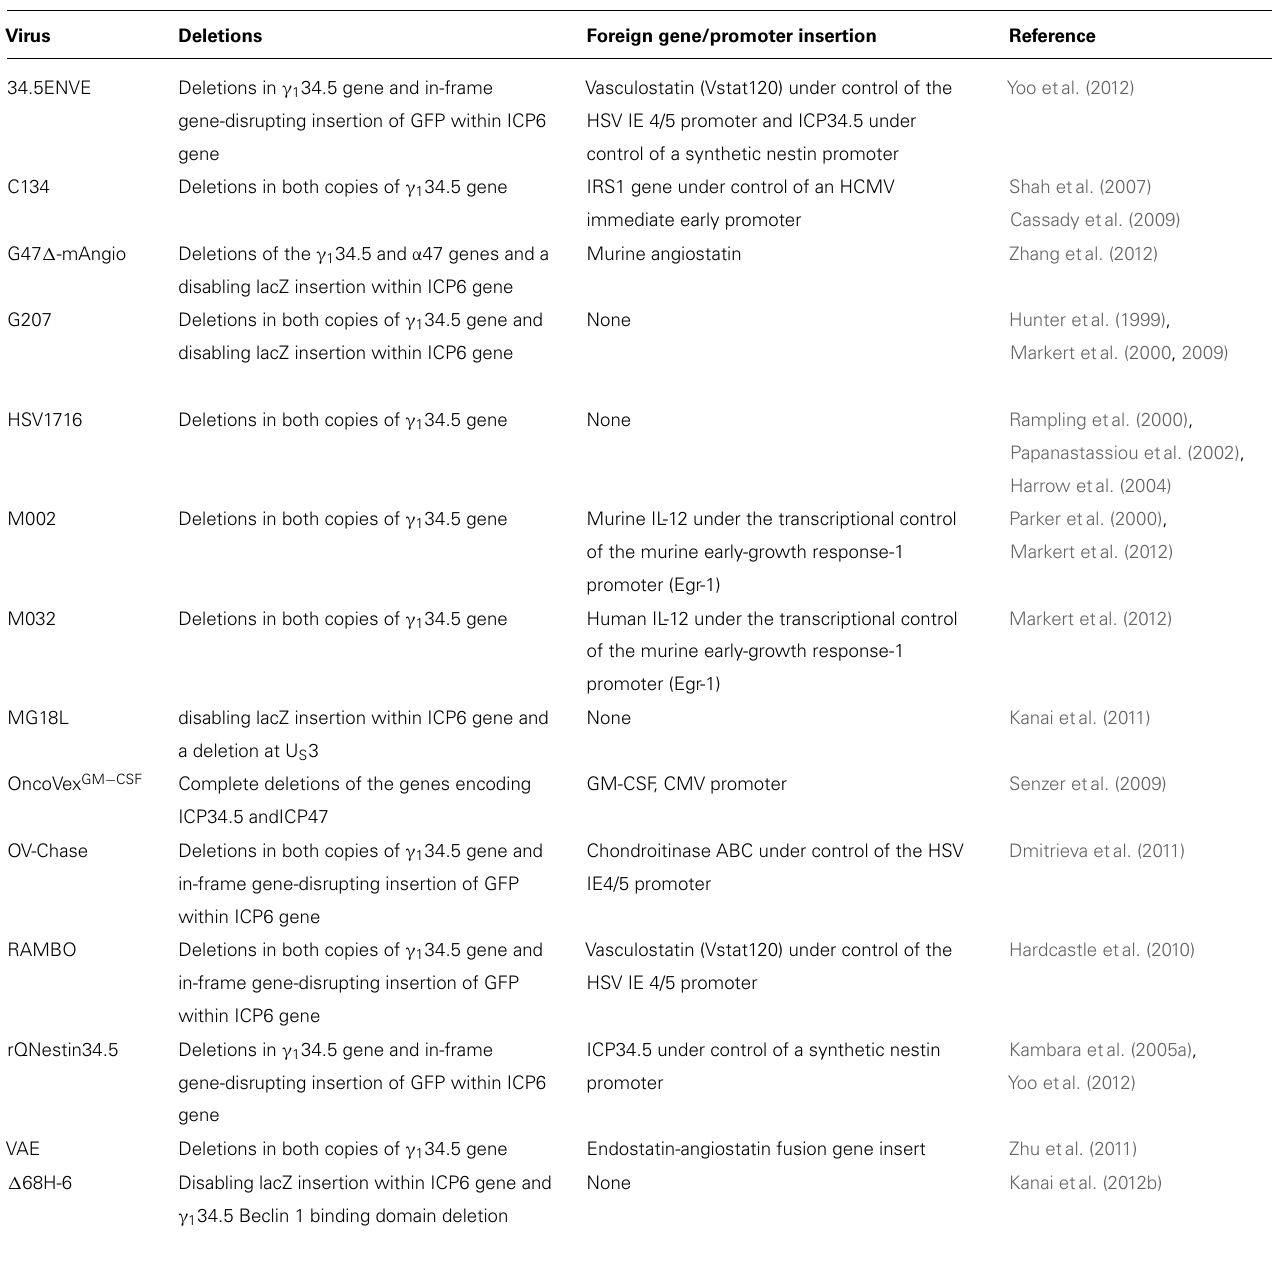
Table 2 | Summary of oncolytic HSVs discussed in the